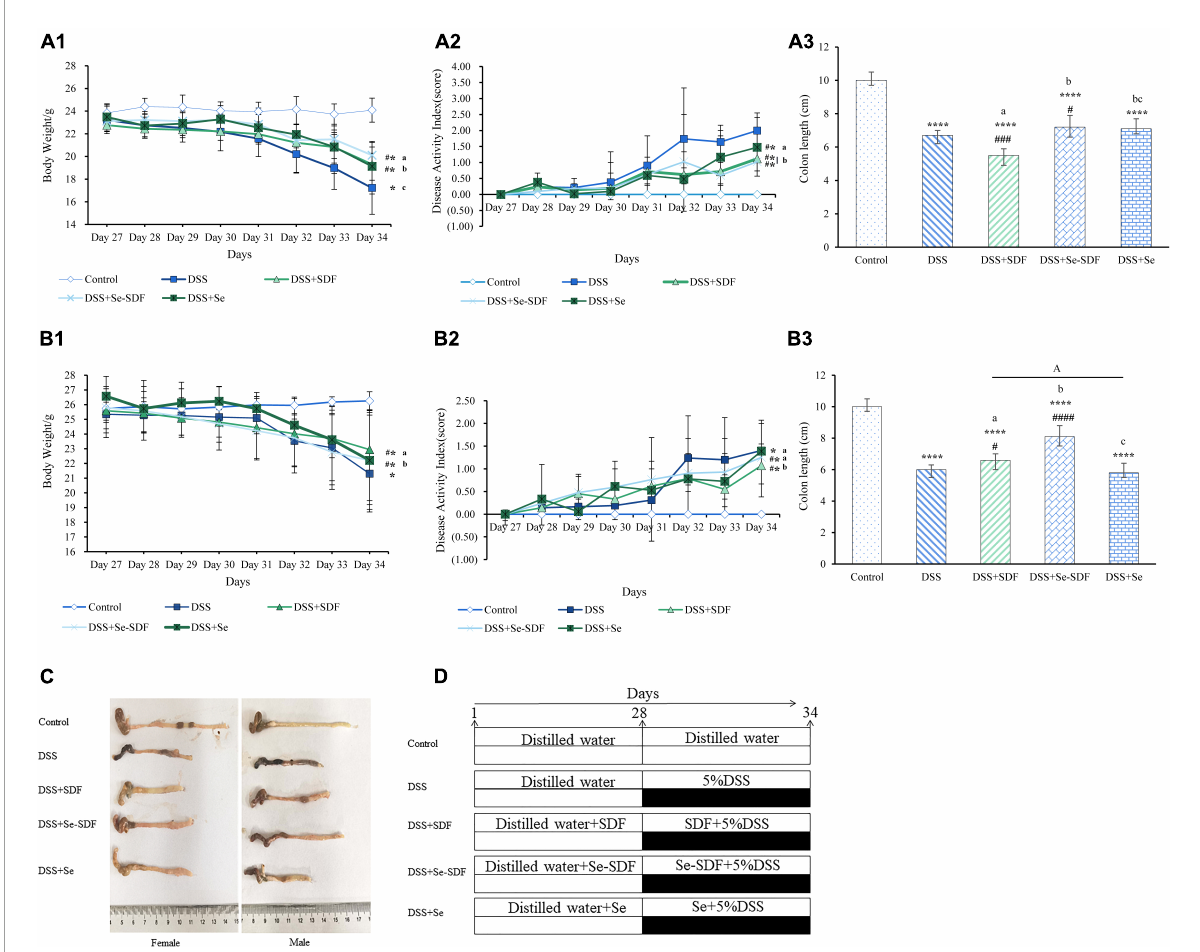
FIGURE1 Effect of Se-SDF on clinical symptoms in mice with DSS-induced colitis. (A 1 –A 3 ) Body weight (g), disease activity index (DAI), and colon length (cm) of female mice. (B 1 –B 3 ) Body weight (g), DAI, and colon length (cm) of male mice. (C) Representative images of the colon from each group. (D) Schematic representation of the experimental design. Data are expressed as mean ± SD ( n = 3). * p < 0.05, ** p < 0.01, *** p < 0.001, **** p < 0.0001 vs. control group. # p < 0.05, ## p < 0.01, ### p < 0.001, #### p < 0.0001 vs. DSS group. Different letters indicate significant differences between groups ( p <